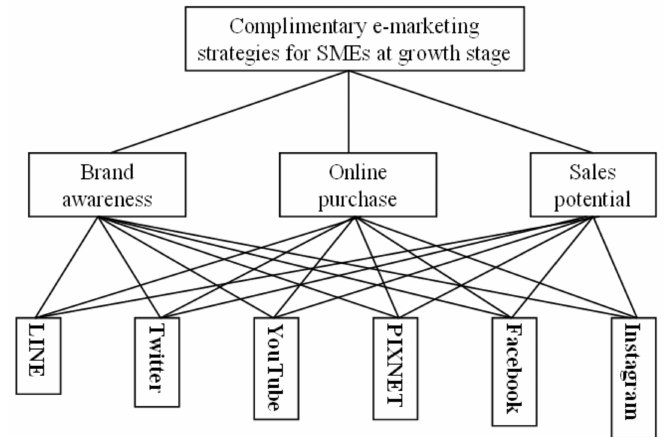
Figure 2. Research framework of this